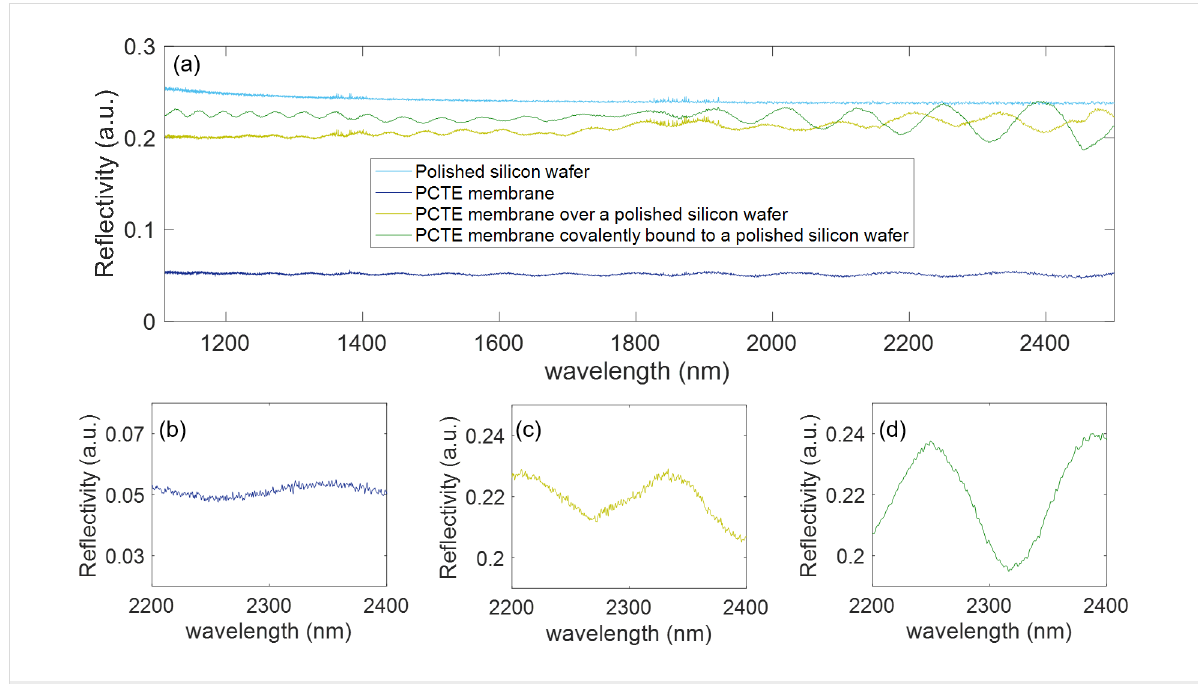
Figure 2: (a) Reflectivity spectra of PCTE membranes surrounded by air, positioned over a silicon substrate and covalently bound to it. Detail of the spectrum between 2200 and 2400 nm for the PCTE membrane (b) surrounded by air, (c) placed over silicon and (d) covalently attached to it. The same vertical scale has been used for the three spectra for a better comparison of the